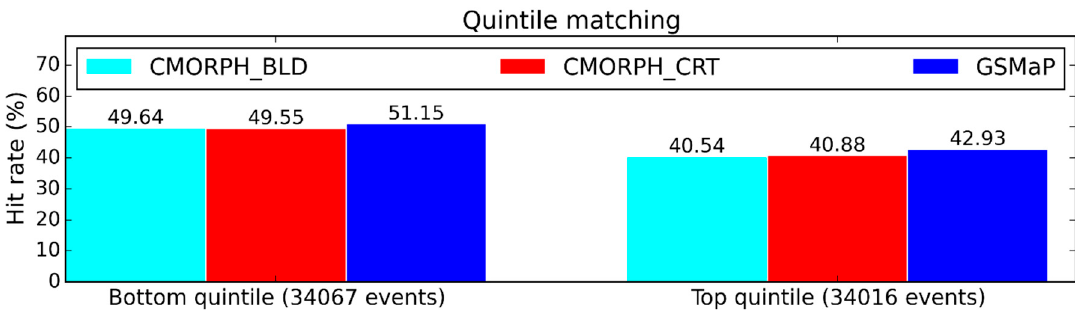
Figure 4. Gridded percentile-based comparison of satellite datasets against ERA5 from January 2001 to December 2018. Bottom- and top-quintile hit rates are displayed.